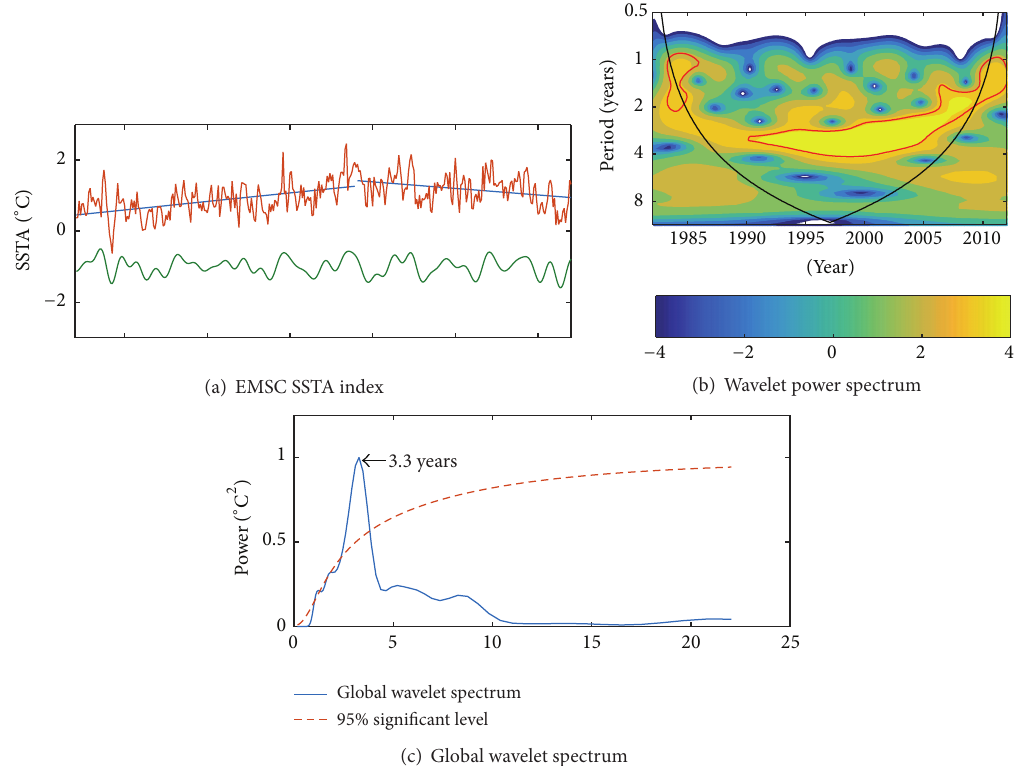
Figure 4: (a) Green curve represents the EMSC SST interannual index constructed by spatial mean SSTA (red curve line) subtracting the warming and cooling trend (blue straight line) and then filtering out signals with period < 1 year and > 8 years. (b) Continuous wavelet power spectrum for EMSC SST interannual index. Shading corresponds to log2(power). The red contour designates the 5% significance level against red noise and the black line indicates the cone of influence (for detailed technique see Torrence and Compo, 1998 [23]; MATLAB code can be obtained from http://paos.colorado.edu/research/wavelets/). (c) Global wavelet spectrum for EMSC SST interannual